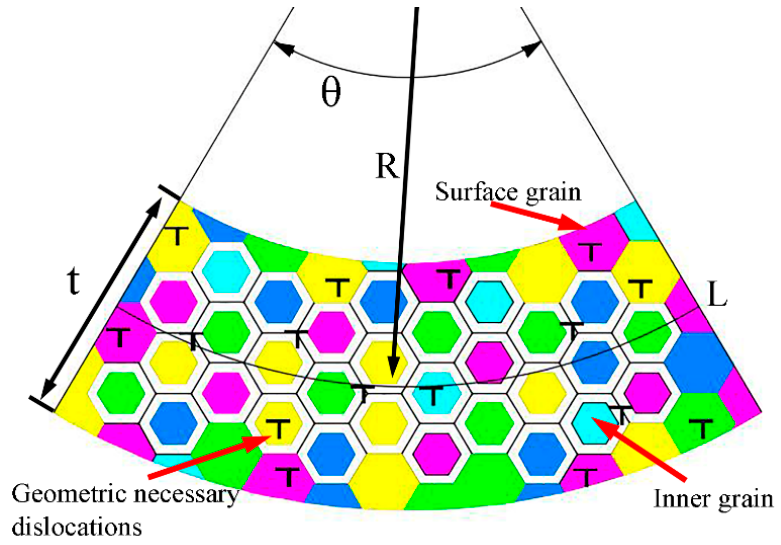
Figure 6. Schematic diagram of the distribution of geometrically necessary dislocations in foil bending.